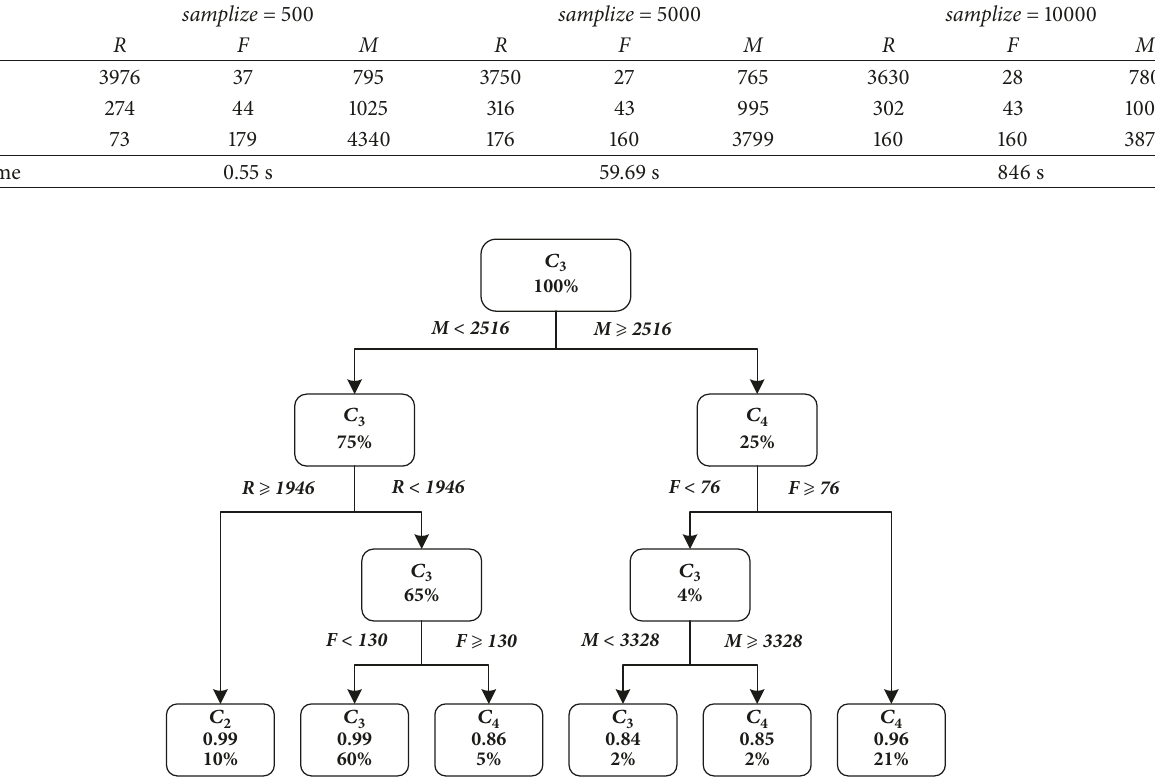
Figure 4: Decision tree of ETC customer